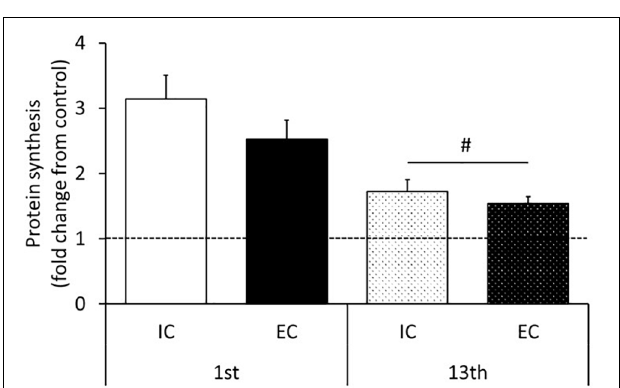
FIGURE 5 | Muscle protein synthesis after the 1st and 13th bouts of exercise. Values are means ± SE. Values are means ± SE. # Main effect of training ( p <